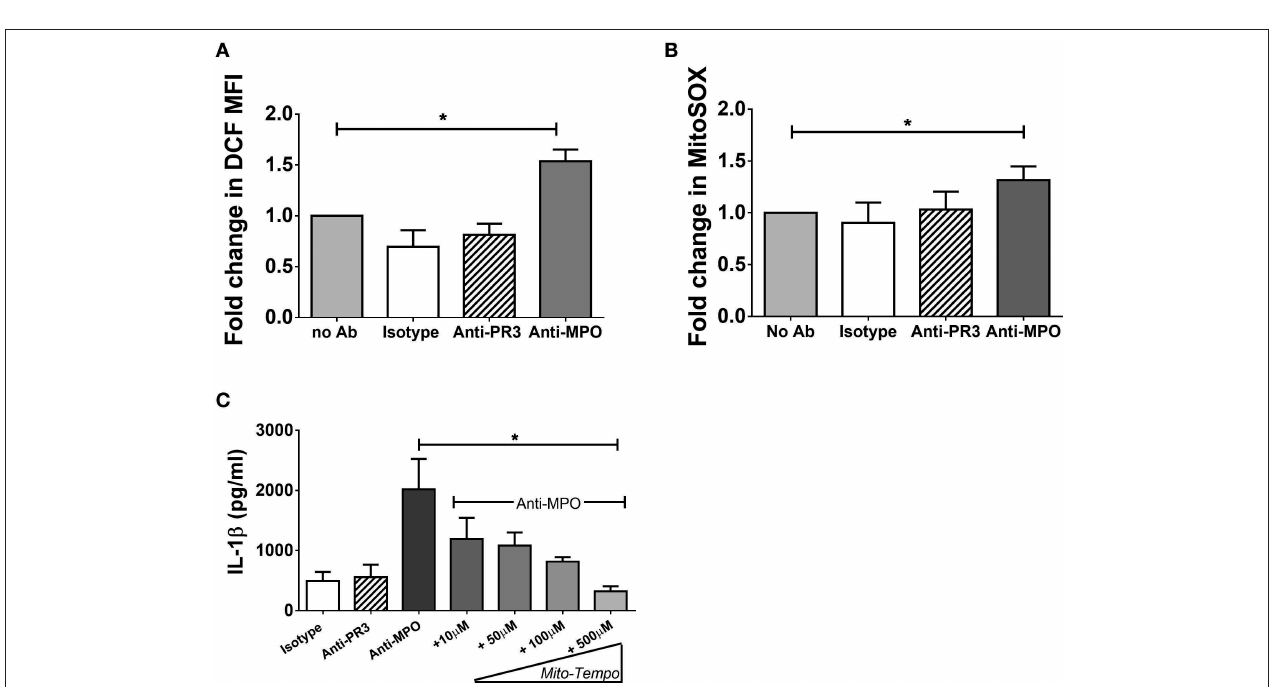
FIGURE 5 | Anti-MPO induced IL-1 β production is abrogated by the mitochondrial ROS scavengers MitoTempo. CD14 + monocytes were incubated with increasing concentrations of MitoTempo followed by stimulation with 5 µ g/ml mAb directed against MPO, PR3, or isotype control antibody. Supernatants were removed and IL-1 β was measured by ELISA (A) . For flow cytometry experiments, monocytes were stimulated as above. CM-H 2 DCFDA (B) or MitoSOX Red (C) was then added to the cells (B) and the MFI was determined by flow cytometry. Statistical analysis was performed by one-way ANOVA with Friedman’s post-test (* p < 0.05) ( n =